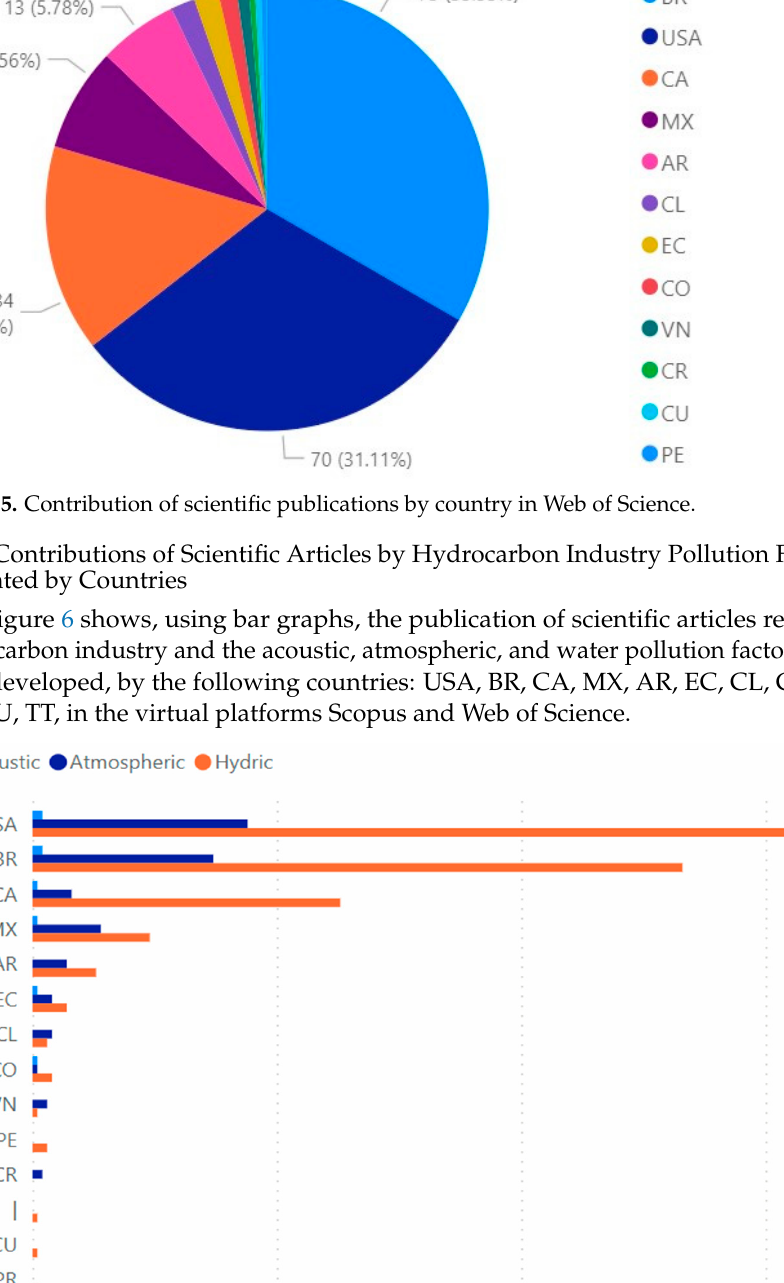
Figure 4. Contribution of scientific publications by country in Scopus.